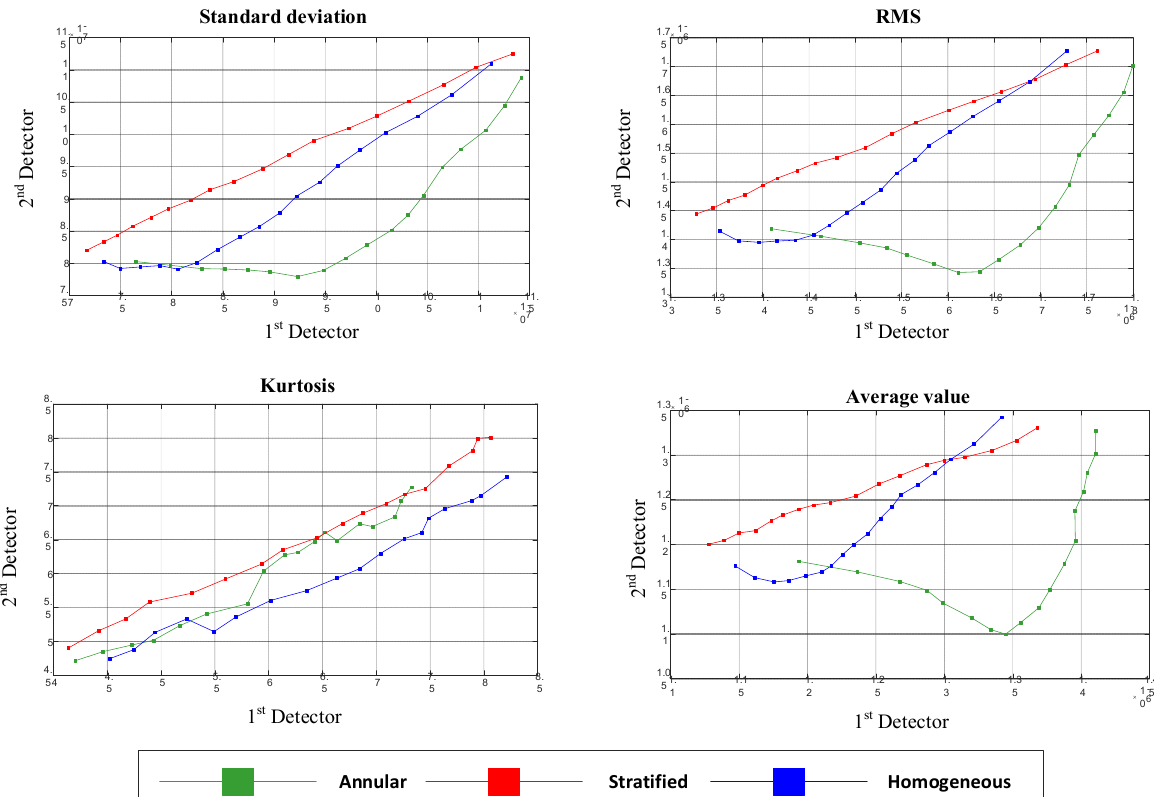
Figure 4. The same features extracted from both detectors.